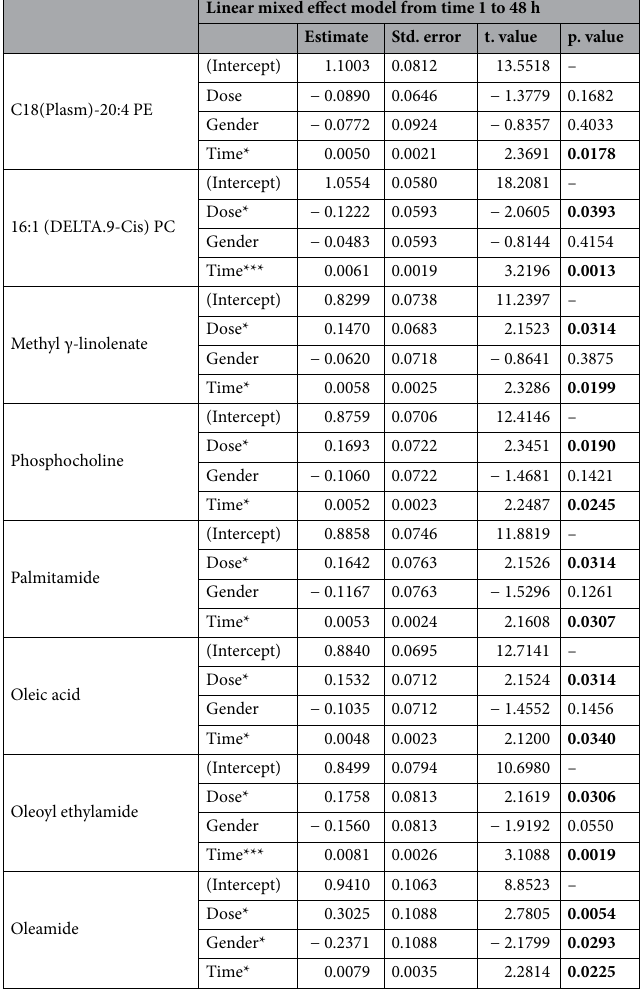
Linear mixed effect model from time 1 to 48 h Estimate Std. error t. value p.